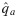
Illustration of procedure to convert discrete hazard functions for hypothetical children to population-level age-specific trends.(A) Discrete hazard functions are estimated for each hypothetical child from each mother in the target SBH dataset. Here, we color all children born in the same year with the same color. Only 3 years are shown for simplicity in this example. In real data, the years of birth of hypothetical children would vary by mother based on her age, such that there would be one hypothetical child for each year going back in time from the survey until the mother was 12 years old. (B) Probability of birth distributions is applied to each hypothetical birth from each mother. These are derived from the empirical map distributions from Rajaratnam and colleagues [9], in which a different probability is available by woman’s age, CEB, region of residence, and year prior to the survey. These probabilities are multiplied by each mother’s CEB and carried through to subsequent age bins to estimate the expected number of children entering each age bin (EEB) using estimated survival probabilities. As such, line thicknesses get slightly smaller with each subsequent age bin. The EEB value for each hypothetical child’s age bin represents the number of children entering that age bin that the hypothetical child represents for their given mother. (C) All hypothetical children to mothers are grouped by year of birth. The estimated mortality probabilities for each age bin from all hypothetical children born in the same year are pooled, and EEB is used to calculate a weighted mean. Trends are drawn across q^a for each year, indicated here by a trend in the third age bin. This aggregation procedure can be done for any grouping of women to make estimates for a survey cluster, a district, or a whole country. CEB, children ever born; EEB, expected entering bin; NN, neonatal; PNN1, post-neonatal 1; PNN2, post-neonatal 2; SBH, summary birth history.